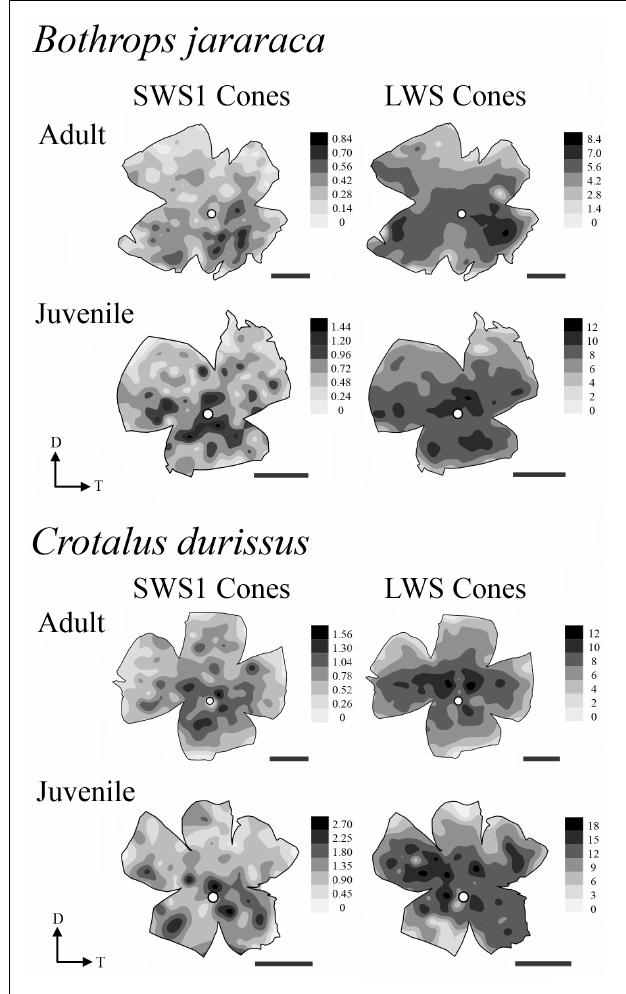
FIGURE 8 | Representative retinal topographic maps of small single SWS1 cones and large single and double LWS cones of adults and juveniles of B. jararaca and C. durissus . Gray bars indicate the density of cells per mm 2 , and values should be multiplied by 10 3 . The optic nerve head is depicted as a white circle. D, dorsal; T, temporal. Scale bars 2